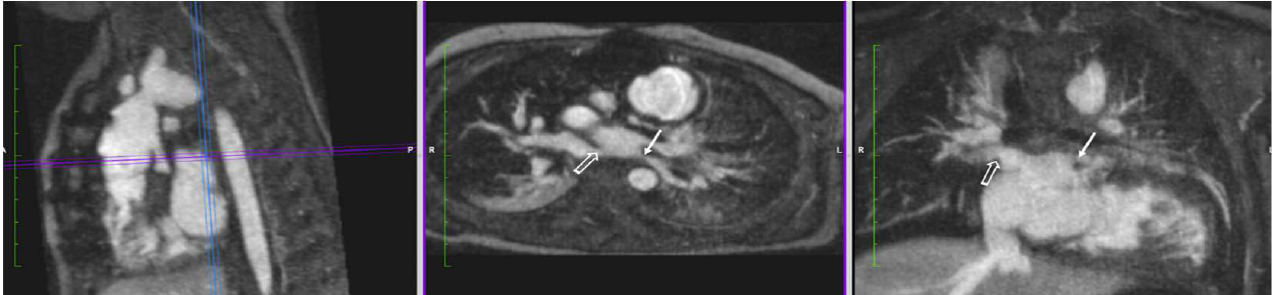
Figure 2. Pulmonary Vein Stenosis (acquired). Reformatted projections from 4D MUSIC images in an infant with hypoplastic left heart syndrome. Acquired postoperative stenosis of the left superior and inferior pulmonary veins after stage I surgical palliation is demonstrated (solid arrows). Narrowed right superior and inferior pulmonary vein ostia are also seen (open arrows).